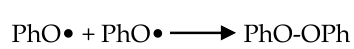
Table 2. Antioxidant classification and source.